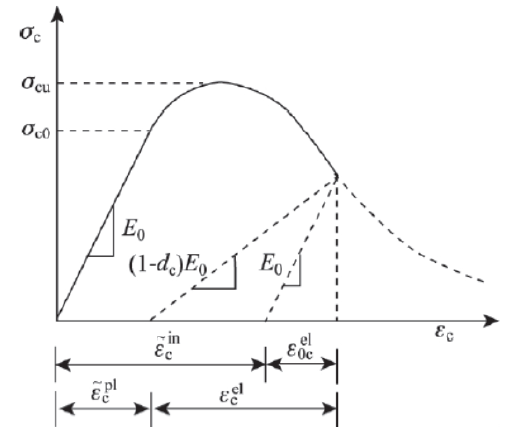
Figure 13. Numerical model. ( a ) Main part of bias column; ( b ) Channel steel; ( c ) Corrugated Steel Sheets.